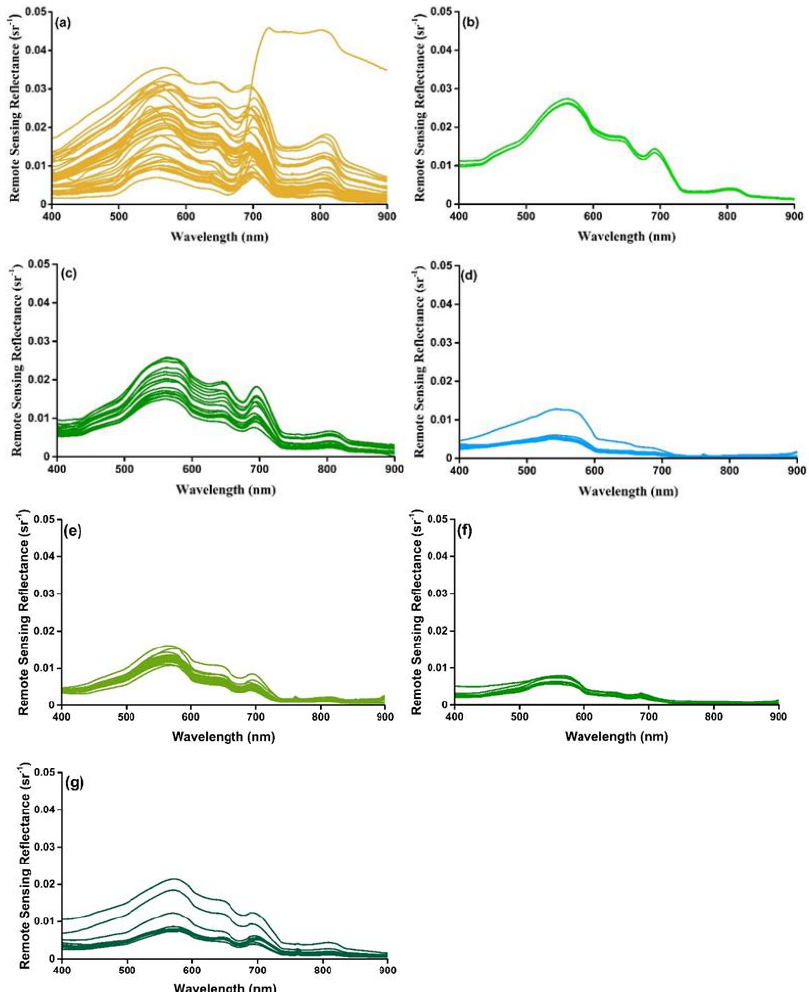
Figure 2. Remote sensing reflectance spectra measured with a field spectrometer at 117 sampling points at: ( a ) Nanfei River, ( b ) The Summer Palace, ( c ) Guanting Reservoir, ( d ) Danjiangkou Reservior, ( e ) Baiguishan Reservoir, ( f ) Xiaolangdi Reservoir, and ( g ) Yuqiao Reservoir.